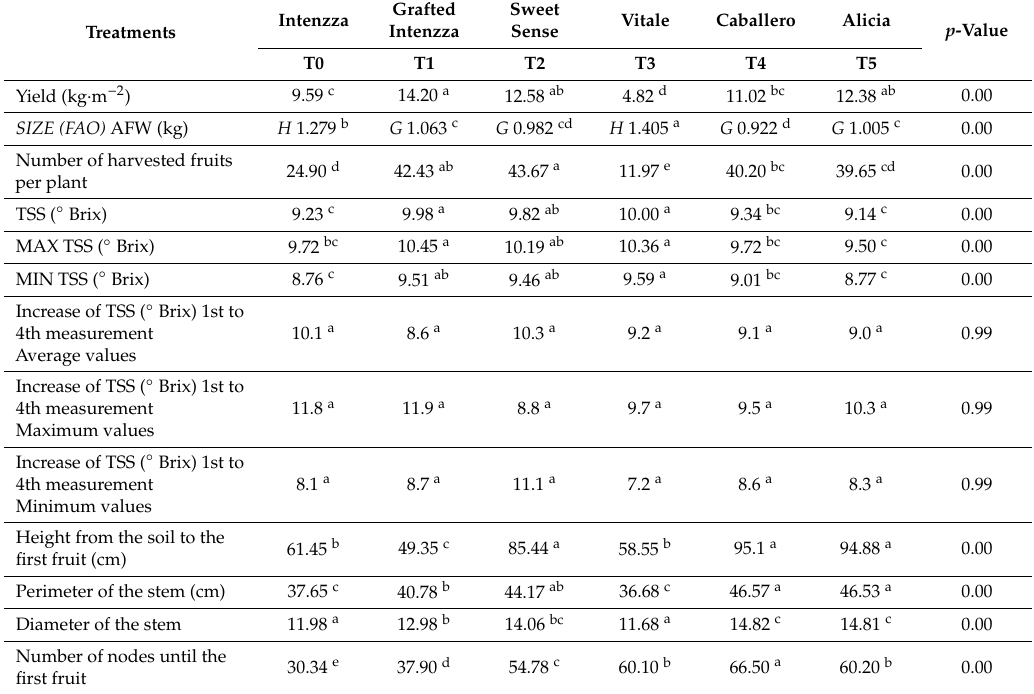
Table 2. Results obtained in papaya grown under greenhouse: Yield (kg · m − 2 ), Average fruit weight (AFW), number of harvested fruits, height from the soil to the first fruit, perimeter of the stem, number of nodes until the first fruit, Total soluble solids (TSS) ( ◦ Brix). Grafted Sweet Intenzza Intenzza Sense Treatments